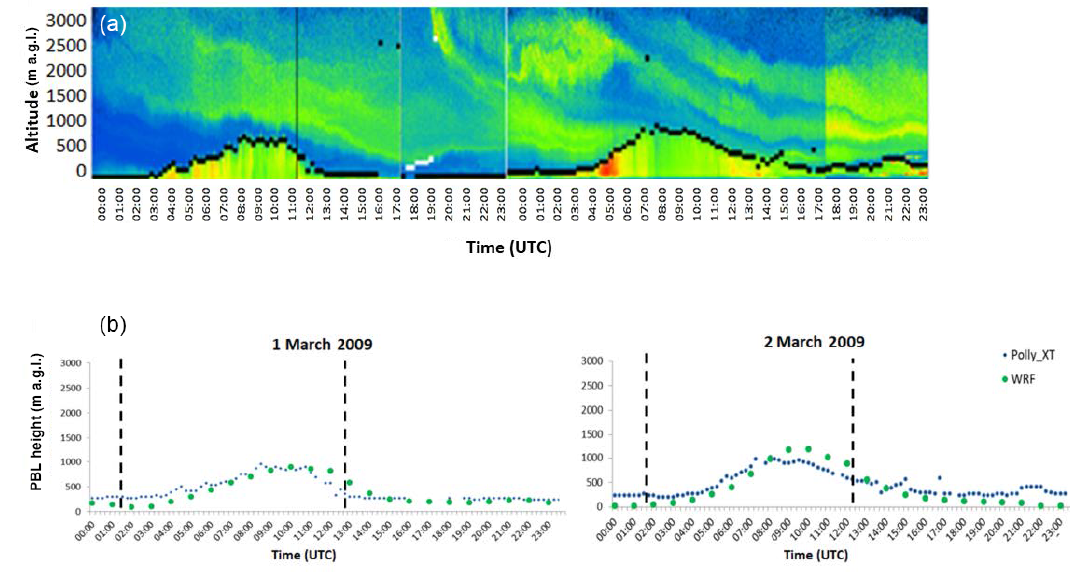
Figure 4. Same as Fig. 3 except for 1–2 March 2009. White horizontal lines (a) indicate 15min cloud base height.